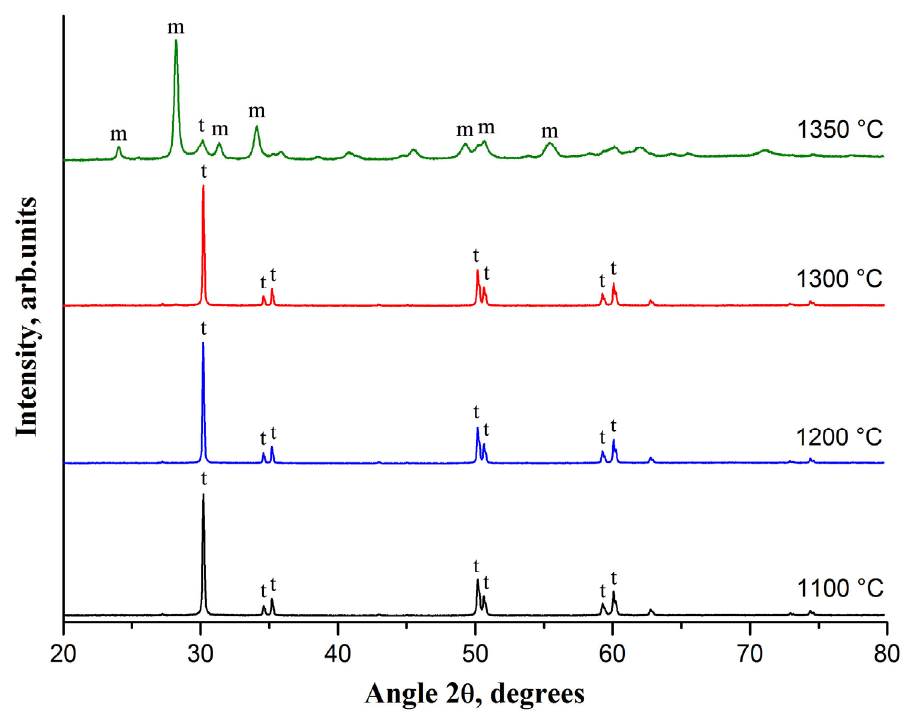
Figure 3. The XRD patterns of 2-wt% CaO-ZrO 2 ceramic sintered at different temperatures; m, t—the most intense characteristic peaks of m-ZrO 2 and t-ZrO 2 ,